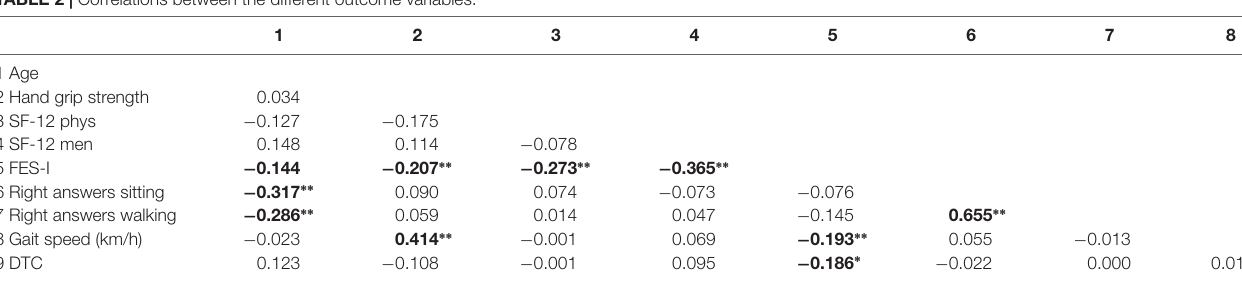
TABLE 2 | Correlations between the different outcome